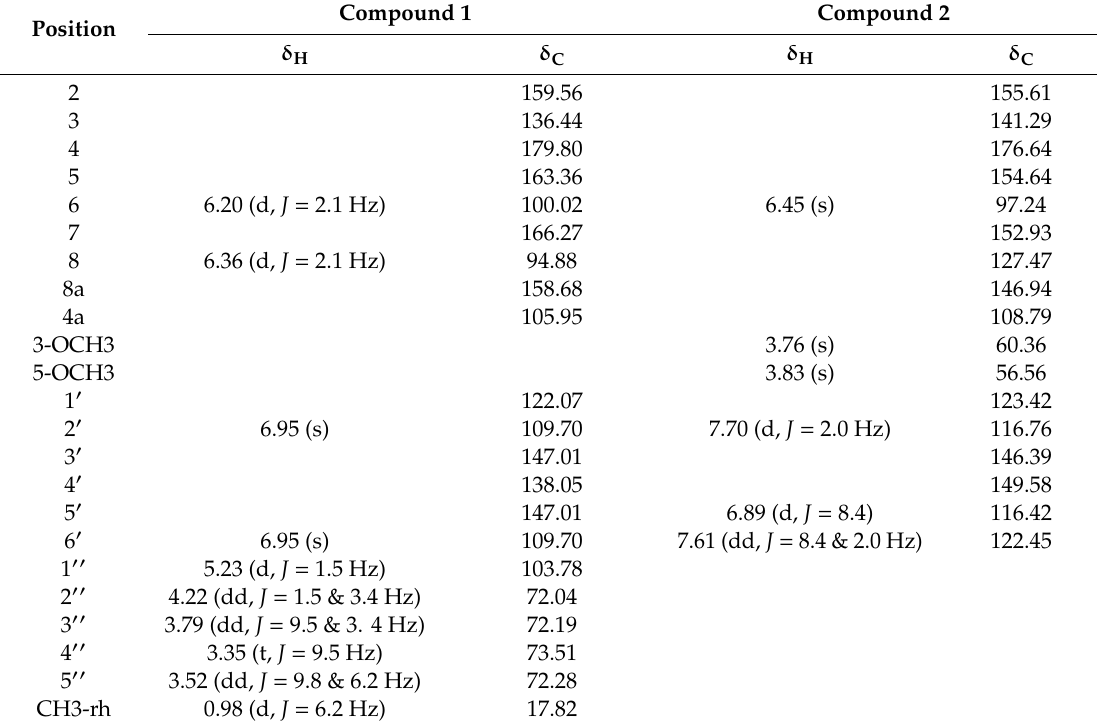
Table 1. 1 H- (500 MHz) and 13 C-NMR (125 MHz) data in (MeOD-d 4 ) for myricetin-3- O - α -rhamnoside